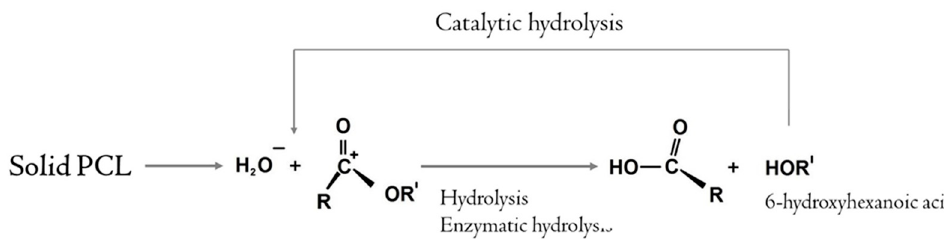
Figure 5. Scheme of ester bond hydrolysis in PCL-microfibers and free-radical-enhanced autocatal-